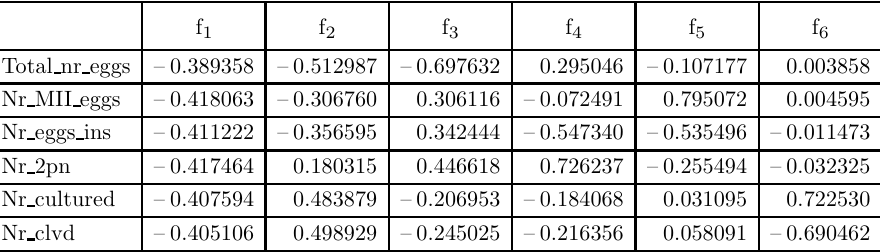
Table 6. Coefficients of the new variables obtained using the PCA method f 1